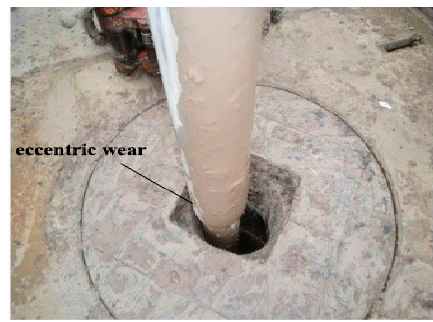
Figure 2. Off-center drill string on site.